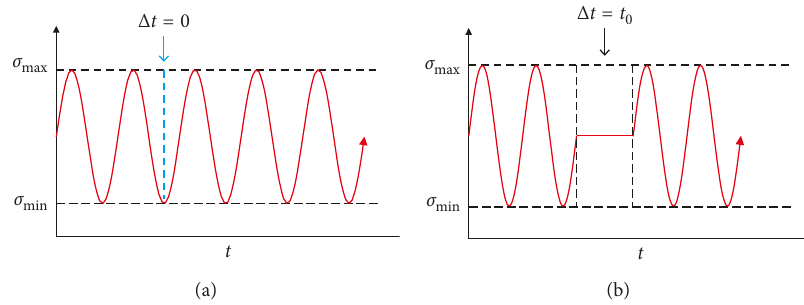
Figure 4: Loading path. (a) Continuous loading path. (b) Discontinuous loading